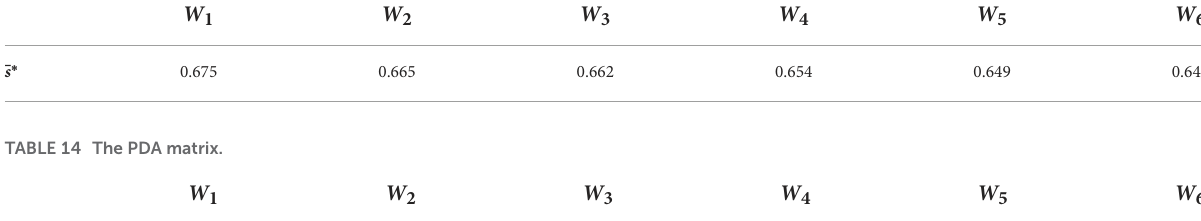
TABLE 13 The average value of score numbers.